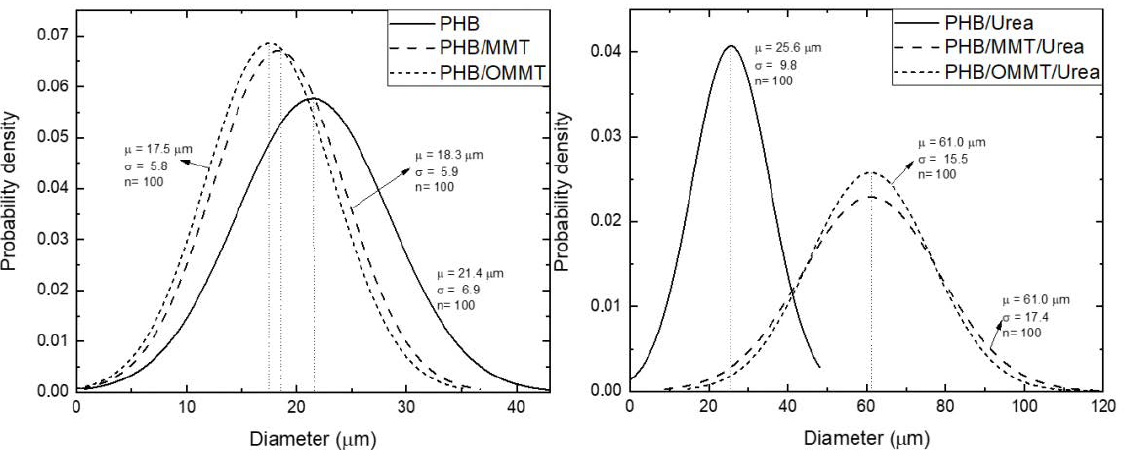
Figure 3. Normal distribution of diameter of PHB, PHB/MMT, and PHB/OMMT microcapsules with and without urea